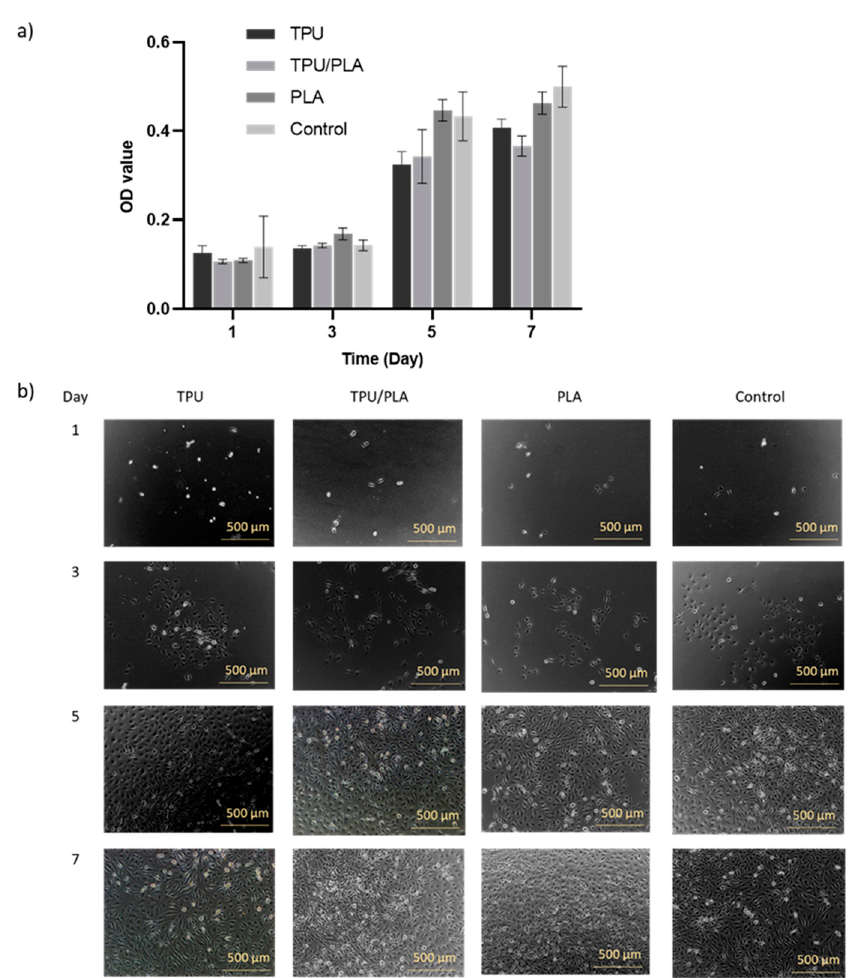
Figure 3. ( a ) Indirect proliferation assay using scaffold extracts. The X -axis represents the incubation time in days, while the Y -axis represents the optical density values of the BEAS-2B cells. In general, the proliferation of BEAS-2B cells was almost consistent from day 1 to day 3 but increased dramatically on day 5 and slowed down on day 7 for all types of scaffolds. Significant proliferation activities were noted between all types of scaffolds over time. ( b ) The proliferation of BEAS-2B cells in immersion media of all scaffold types. Phase contrast micrographs showing the percentage of confluence of proliferating BEAS-2B cells at days 1, 3, 5, and 7. It was noted that the confluences of the cells in all groups were almost similar. Scale bar: 500 µ